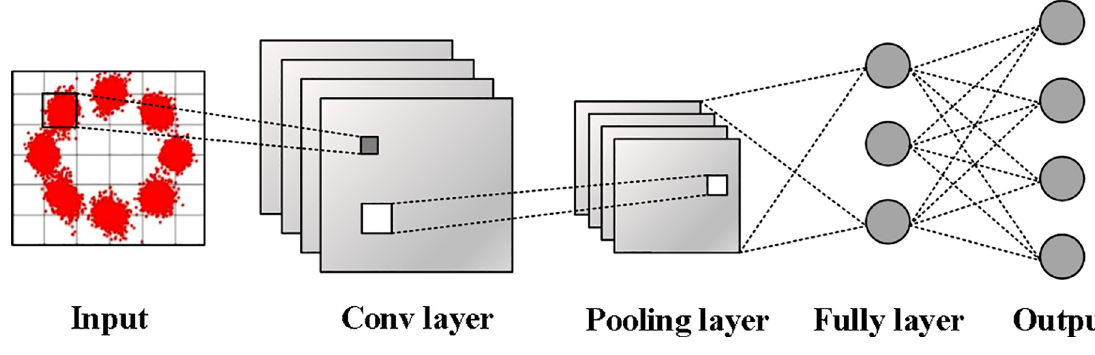
Fig 2. Basic structure of